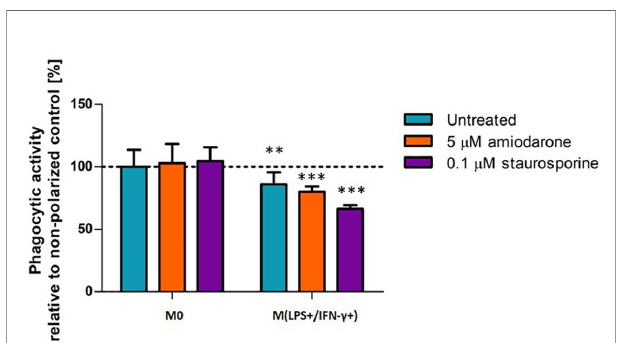
FIGURE 7 | Phagocytic activity in M0-non-activated, LPS/IFN- g or IL-4 activated NR8383 rat macrophages after 24 h exposure to 5 µM amiodarone (orange bars) and 0.1 µM staurosporine (purple bars). Data are expressed as a percentage of the phagocytic activity of non-polarized untreated NR8383 cells. Data represent the mean values ± SEM of three separate experiments. Statistical comparisons are made using a one-way ANOVA analysis with Bonferroni ’ s multiple comparison post-hoc test. Results are compared to non-polarized control (M0); ** indicate p < 0.01, *** indicates p <